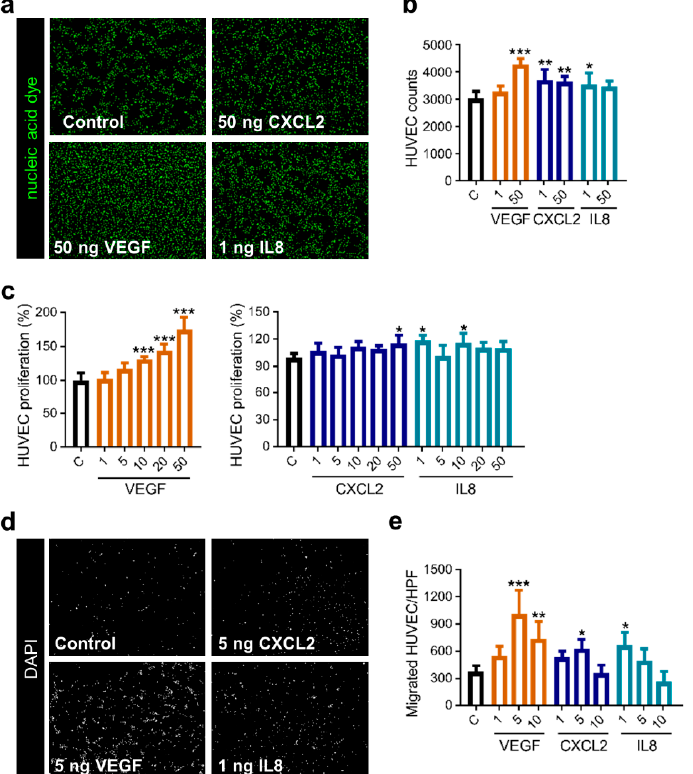
Figure 4. Stimulation with CXCL2 and IL8 promotes proliferation and migration of HUVEC. ( a – c ) CyQUANT assay was performed with HUVEC, adding recombinant proteins as indicated (ng/mL). Representative images of the nucleic acid stain are depicted ( a ). Graph shows counted cells from one representative experiment of three independent experiments with similar results ( n = 4–5 wells/condition) ( b ). Graphs illustrate calculation of proliferation measured by fluorescence inten- sity from one representative experiment of three independent experiments with similar results ( n = 4–5 wells/condition) ( c ). * p < 0.05, ** p < 0.01, *** p < 0.001; one-way ANOVA. ( d , e ) Migration of HUVEC was accessed using a Boyden chamber assay in reaction to VEGF, CXCL2 and IL8 in differ- ent concentrations (ng/mL). Images depict one representative high-power field (HPF; magnification: 200×) for the respective condition ( d ). Graph represents one experiment of four independent exper- iments with similar results ( n = 3–4 membranes/condition) ( e ). * p < 0.05, ** p < 0.01, *** p < 0.001; one-way ANOVA.